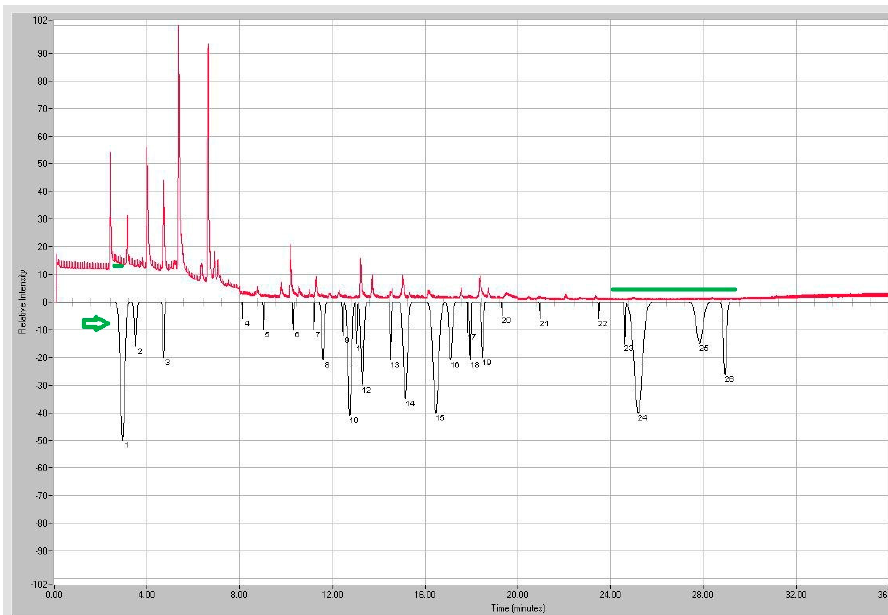
Figure 2. An overlay of the aromagram and total ion chromatogram of the fresh cat urine exposed to SPME fiber for 50 min at 37 °C: an increase in the black signal height represents an increased intensity of odor, and the chromatogram is in red for total ion chromatogram (TIC) signal. The green zone shows that trace levels of the concentration of malodors can produce an intense olfactory response detected by the panelist using GC–MS–O.